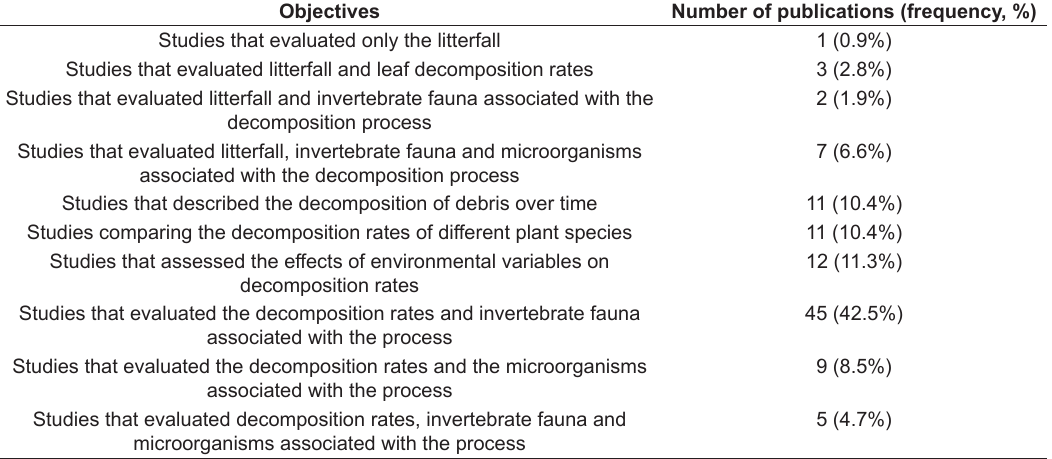
Table 4. Description of the objectives and number of publications about decomposition in aquatic environments at the subtropical region of South America.